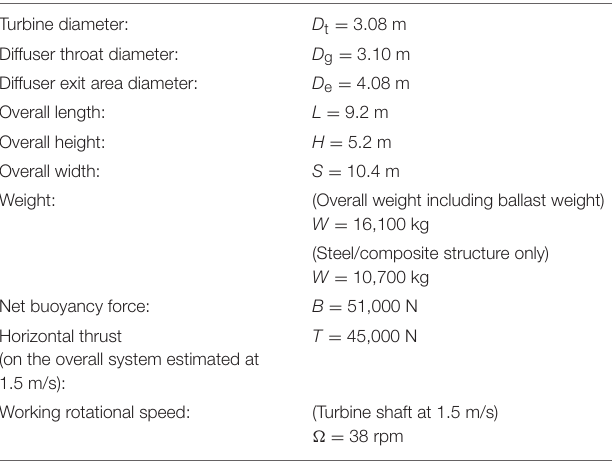
TABLE 3 | GEM prototype geometrical